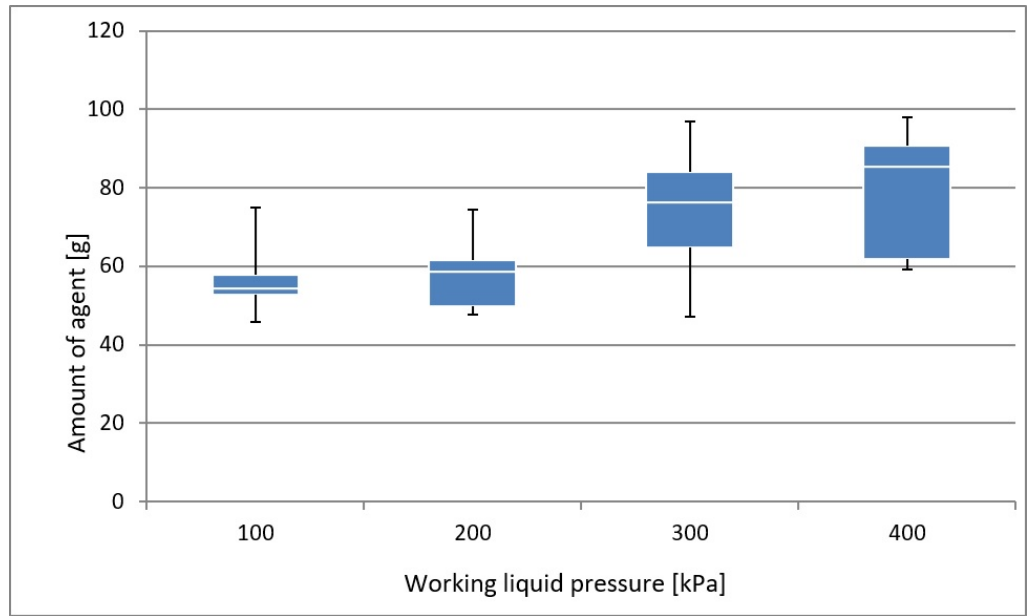
Figure 8. The amount of the agent lost (applied outside the surface of seed potatoes) for a valve without electronic control at a distance of 50 mm between the valve and the seed potato falling path (continuous stream of the liquid).